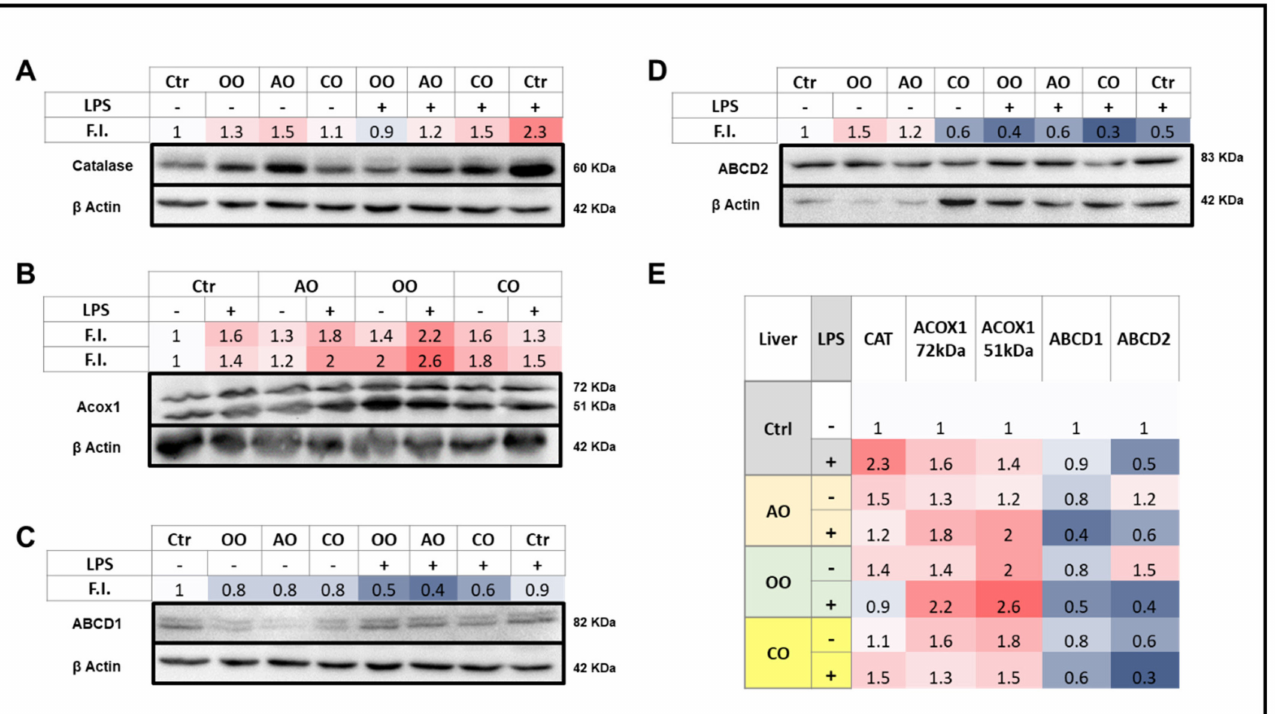
Figure 5. Effect of argan oil, olive oil or colza oil treatment on liver expressions of peroxisomal proteins, CAT ( A ), ACOX1 ( B ), ABCD1 ( C ), ABCD2 ( D ) and the heatmap for all protein expression ( E ). Male C57BL/6 mice received for 28 days a standard diet (control (CTRL)), a diet enriched with 6% ( w / w ) AO, OO, or CO, and intravenous injection of LPS (100 µ g) four hours antemortem. Liver homogenates were prepared as described in Section 4. Band intensities were analyzed by densitometry and standardized to β -actin expression level. Tables represent the standardized densitometric analysis obtained after signal intensity quantification of different